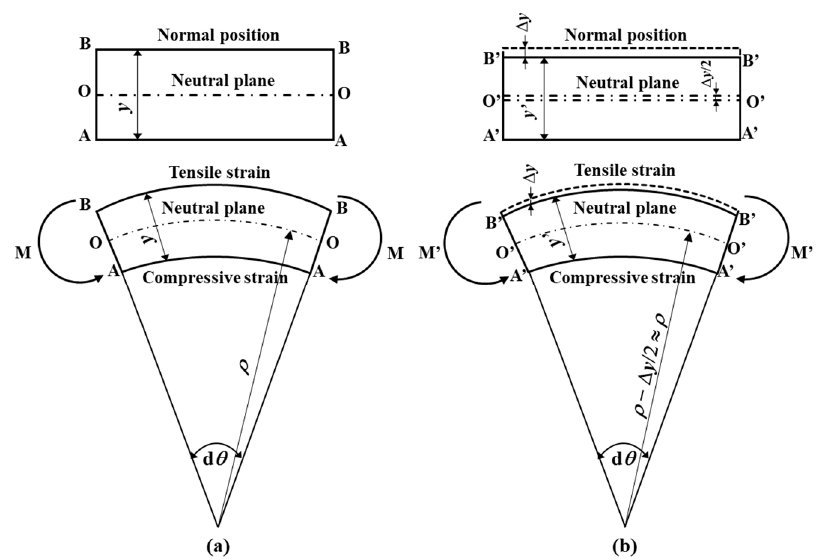
Figure 1. Schematic of test piece subjected to moments M and M’. ( a ) Initial conditions; ( b ) after the test piece thickness decreases upon corrosion.